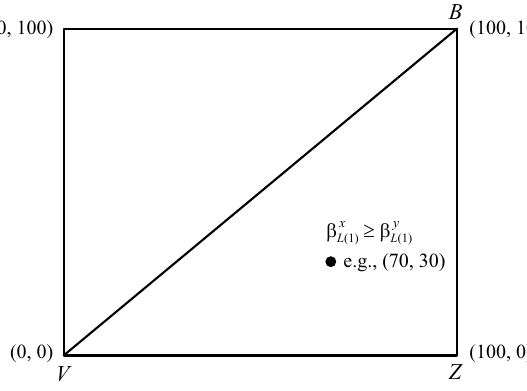
Fig. 2. The consumer’s pre-alliance beliefs about L